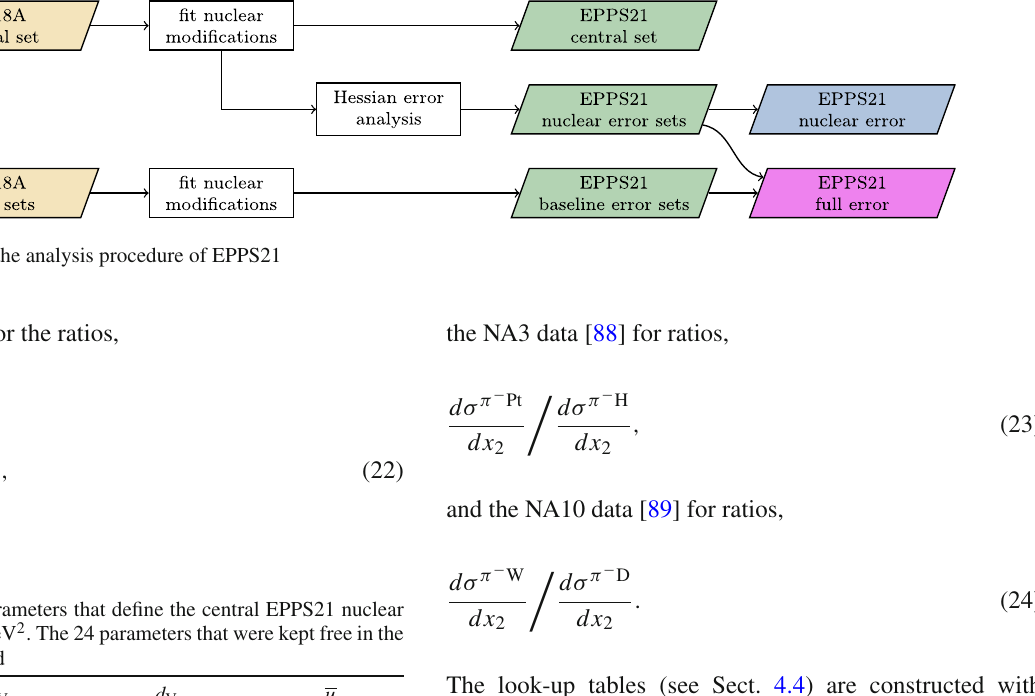
and the NA10 data [89] for